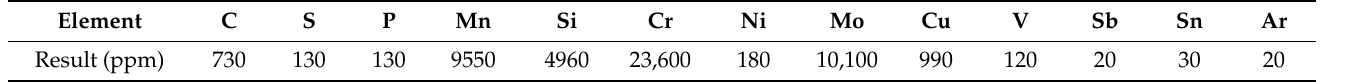
Table 4. Chemical composition of weldment after